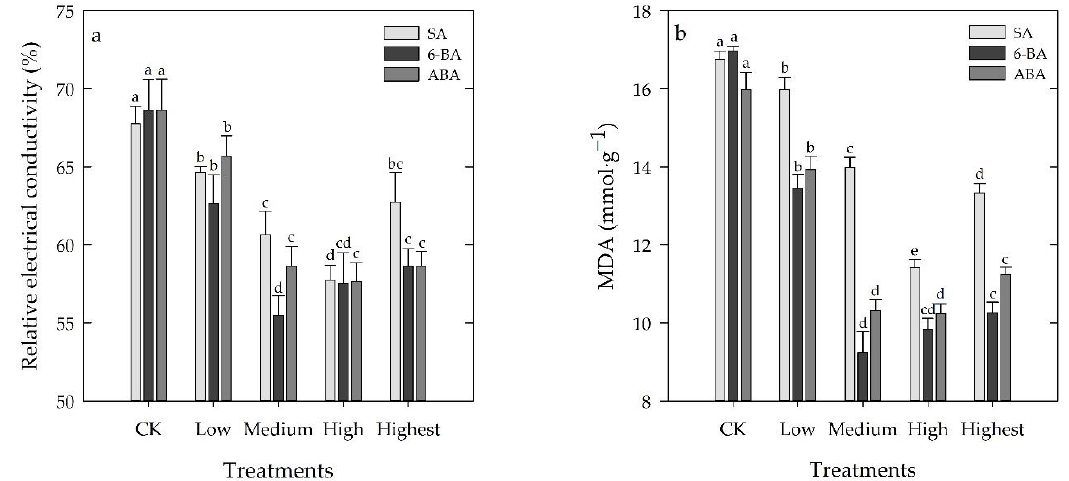
Figure 4. Effects of different concentrations of SA, 6-BA, or ABA on the relative electrical conductivity (REC, ( a )) and MDA content ( b ) of Rosa hybrida ‘Carolla’. CK: distilled water. Low, 0.5 mmol · L − 1 SA, 10 µ mol · L − 1 6-BA, 37.5 µ mol · L − 1 ABA; medium: 1.0 mmol · L − 1 SA, 20 µ mol · L − 1 6-BA, 75 µ mol · L − 1 ABA; high: 1.5 mmol · L − 1 SA, 30 µ mol · L − 1 6-BA, 112.5 µ mol · L − 1 ABA; highest: 2.0 mmol · L − 1 SA, 50 µ mol · L − 1 6-BA, 187.5 µ mol · L − 1 ABA; Vertical bars denote standard errors ( n = 10). The values are described as the means ± SD; different letters denote significant differences ( p < 0.05) according to Duncan’s multiple range test s.